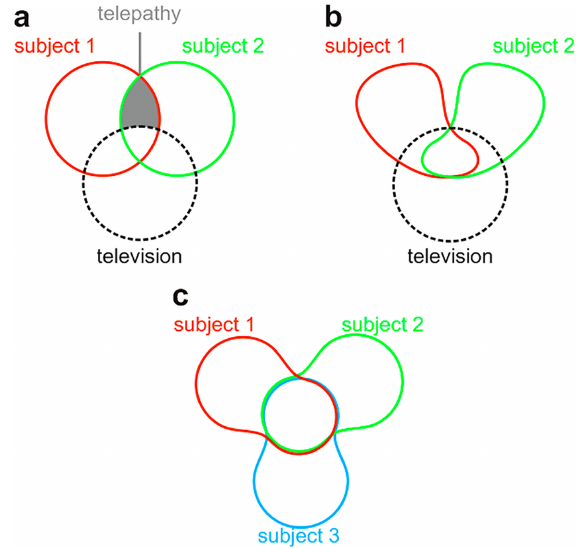
Figure 1 . Venn diagrams of mutual information between subject brains and a common complex input. The areas of the shapes represent the information in a stimulus stream or in a subject ’ s brain. Overlap represents mutual information. (a) When two subjects (red, green) perceive the same stimulus stream (televi- sion), their brains share information time-locked to the stimulus stream. If the subjects are isolated from each other, any mutual information between their brains (red – green overlap) must re fl ect either the common input (television), or a telepathic connection (gray). (b) Assuming that the subjects are not telepathically connected, any intersubject information (red – green overlap) must re fl ect the common input (television). (c) Given only brain activity time-locked to a common stimulus stream for a group of subjects, but no description of the stimulus, we can infer whether a given brain region is driven by some aspect of the stimulus stream by detecting intersubject